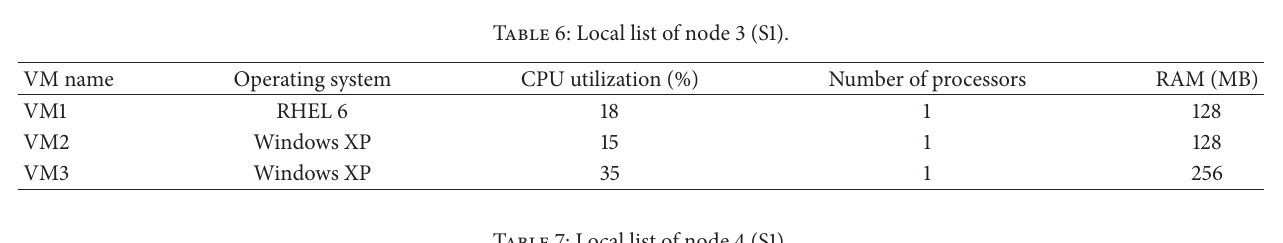
Table 7: Local list of node 4 (S1).